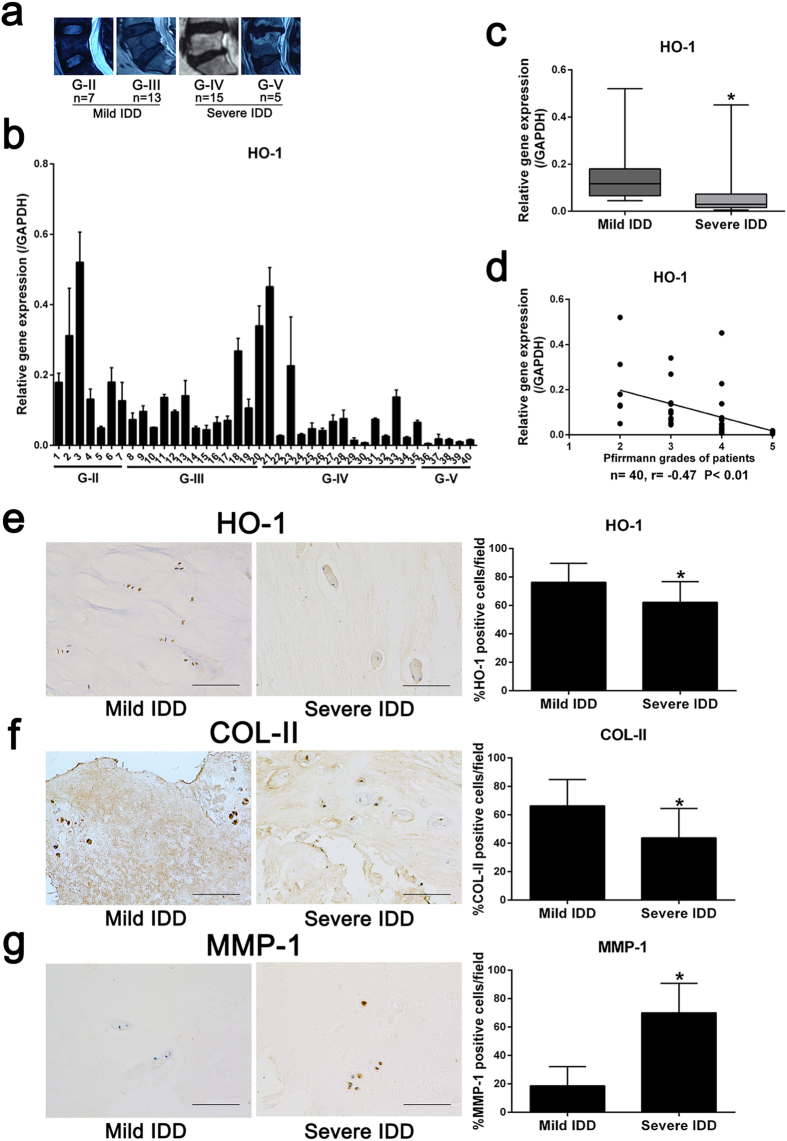
The expression of HO-1 in human nucleus pulposus tissues (a) Disc tissues from patients were collected and classified according to the modified Pfirrmann grading system, and samples of grade II/III (n = 20) were assigned to the mild IDD group, while samples of grade IV/V (n = 20) were allocated to the severe IDD group. (b) Real-time PCR of human degenerated intervertebral disc samples showed that the expression of HO-1 is consistently higher in the Grade II and Grade III (mild degeneration) samples than in Grade IV and Grade V (severe degeneration) samples. The results were normalized to the expression of GAPDH. (n = 40, mild IDD = 20, severe IDD = 20). (c) We further pooled the samples into two groups according to the clinical significance (mild and severe IDD), and the whisker box plot showed the HO-1 expression is considerably higher in mild than severe groups. (d) Gene expression of HO-1 was negatively correlated with the Pfirrmann grades of 40 human NP tissues (n = 40, r = −0.47). Immunohistochemistry of the human NP sections showed that numbers of HO-1 (e) and COL-II (f) -positive cells in the mild IDD group were remarkably decreased compared with those in the severe IDD group. The number of cells immunopositive for MMP-1 (g) were substantially higher in severe IDD compared with those in mild IDD NP tissues. Values represent the mean and standard deviation (SD). *P < 0.05, bars = 100 μm.